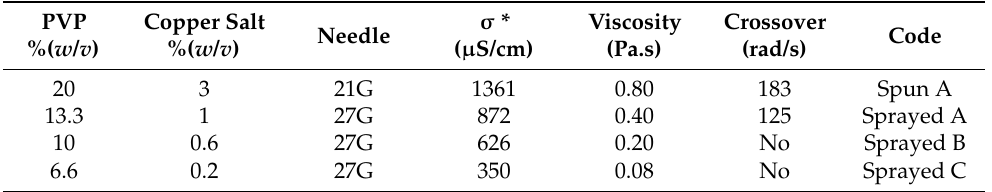
Table 1. Formulation concentrations, needles, electrical conductivity, rheological properties, and coding of electrospinning and electrospraying solutions.